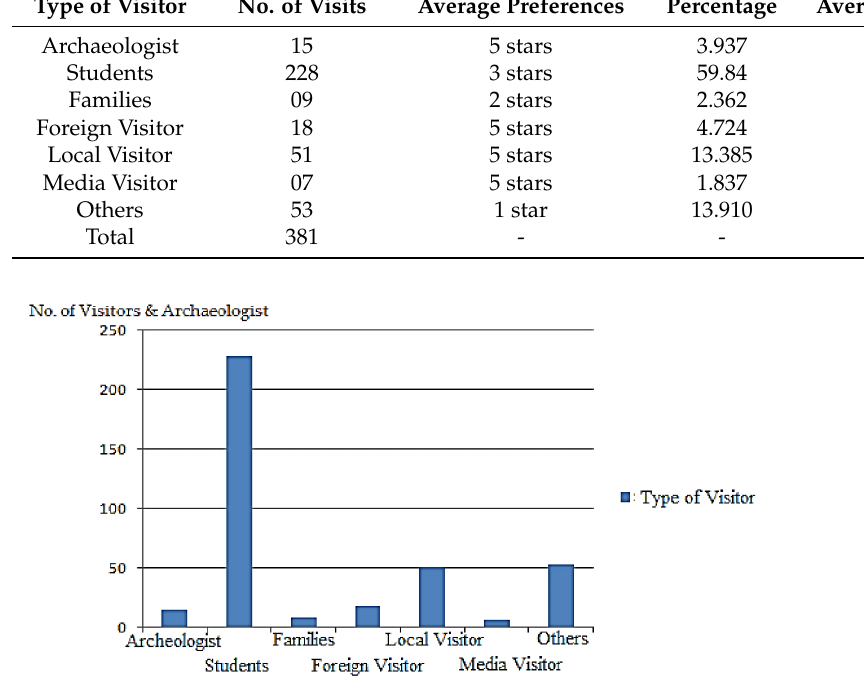
Figure 16. Types and numbers of